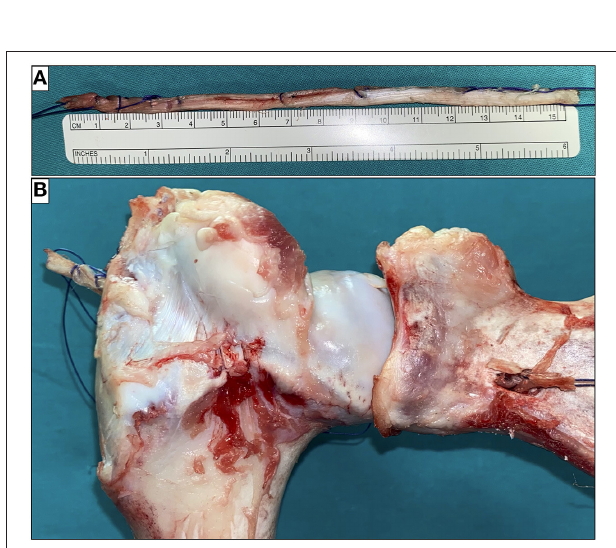
hole was drilled on the wire guide. The length of the tunnel